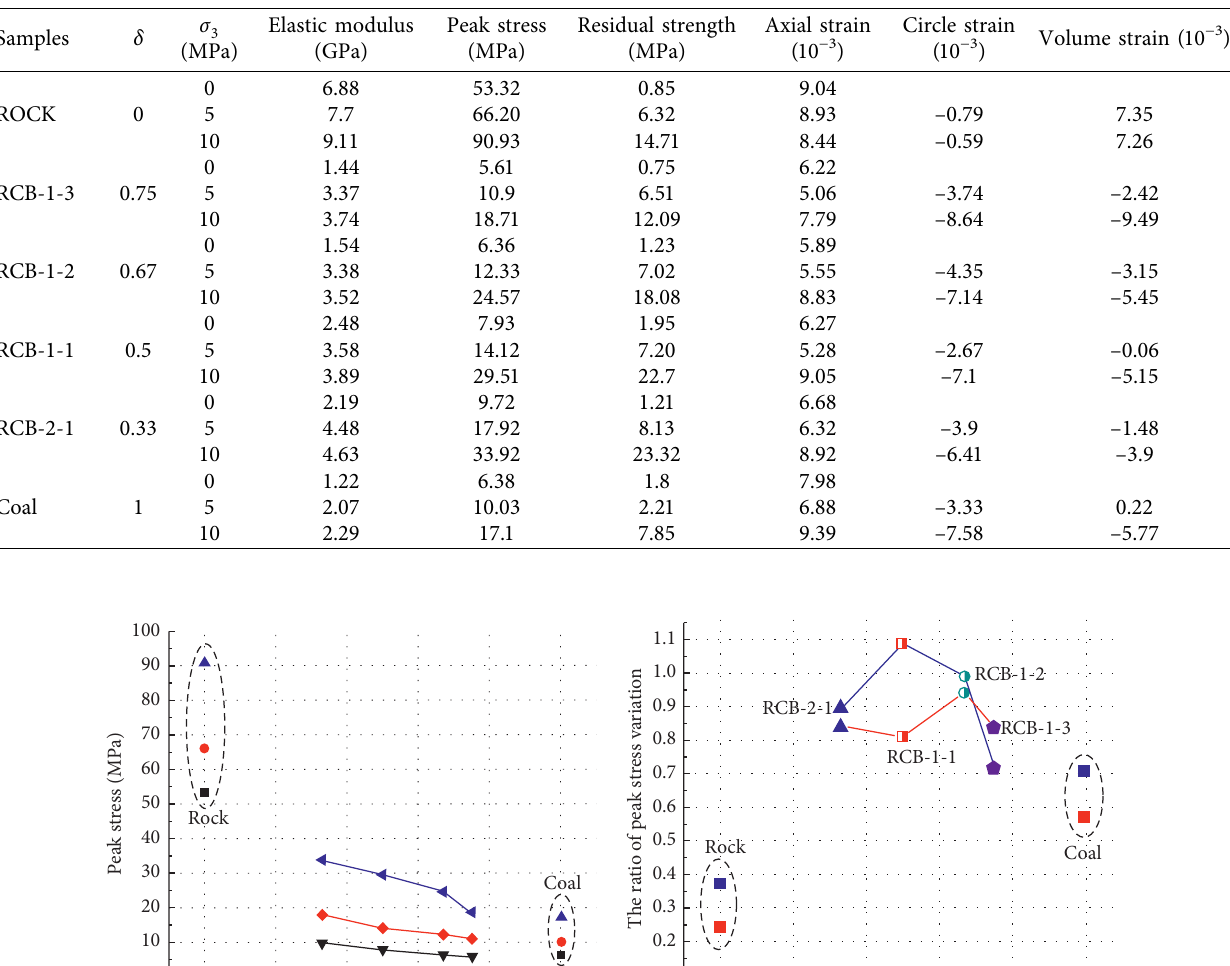
Table 2: Test results of coal and rock pure samples and coal-rock combined samples.